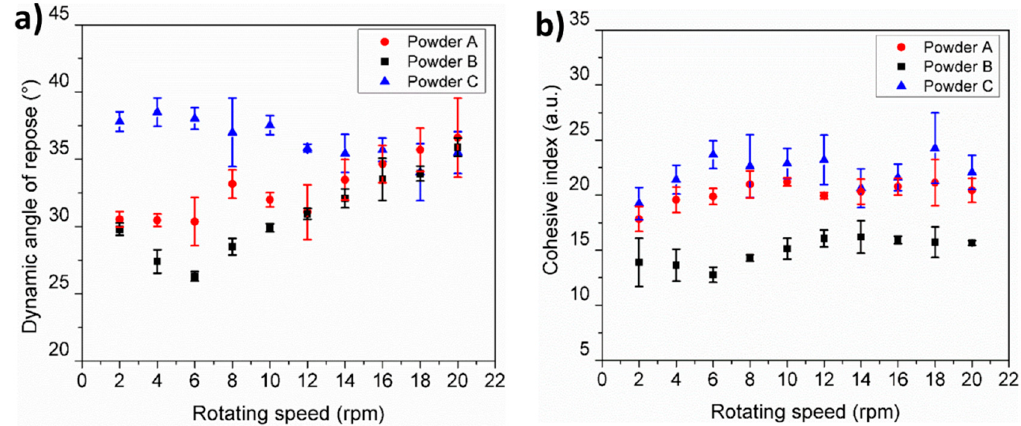
Figure 9. ( a ) Dynamic angle of repose and ( b ) cohesive index determined for powders A, B, and